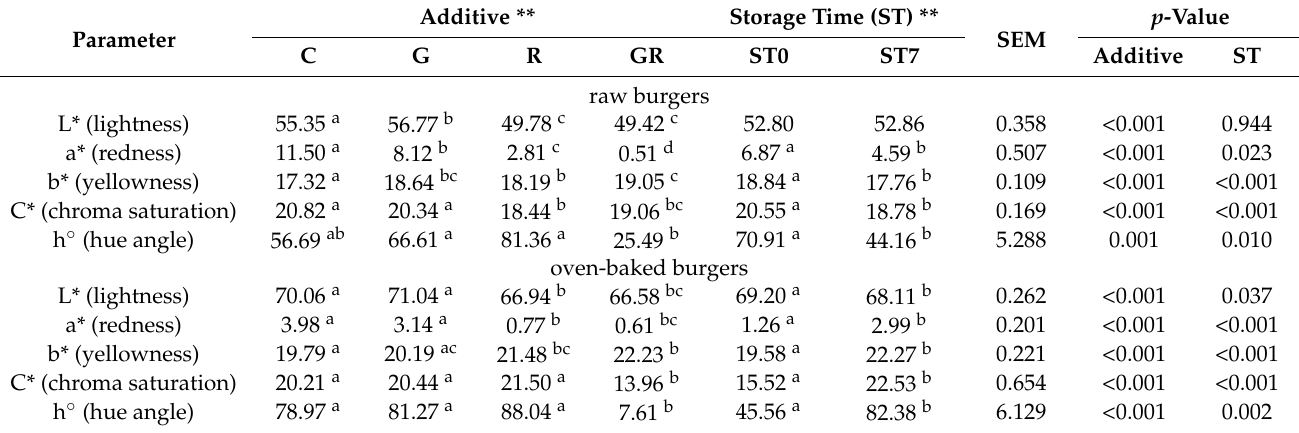
Table 2. Color parameters (L*, a*, b*, C*, h ◦ ) of raw and oven-baked burgers (means ±